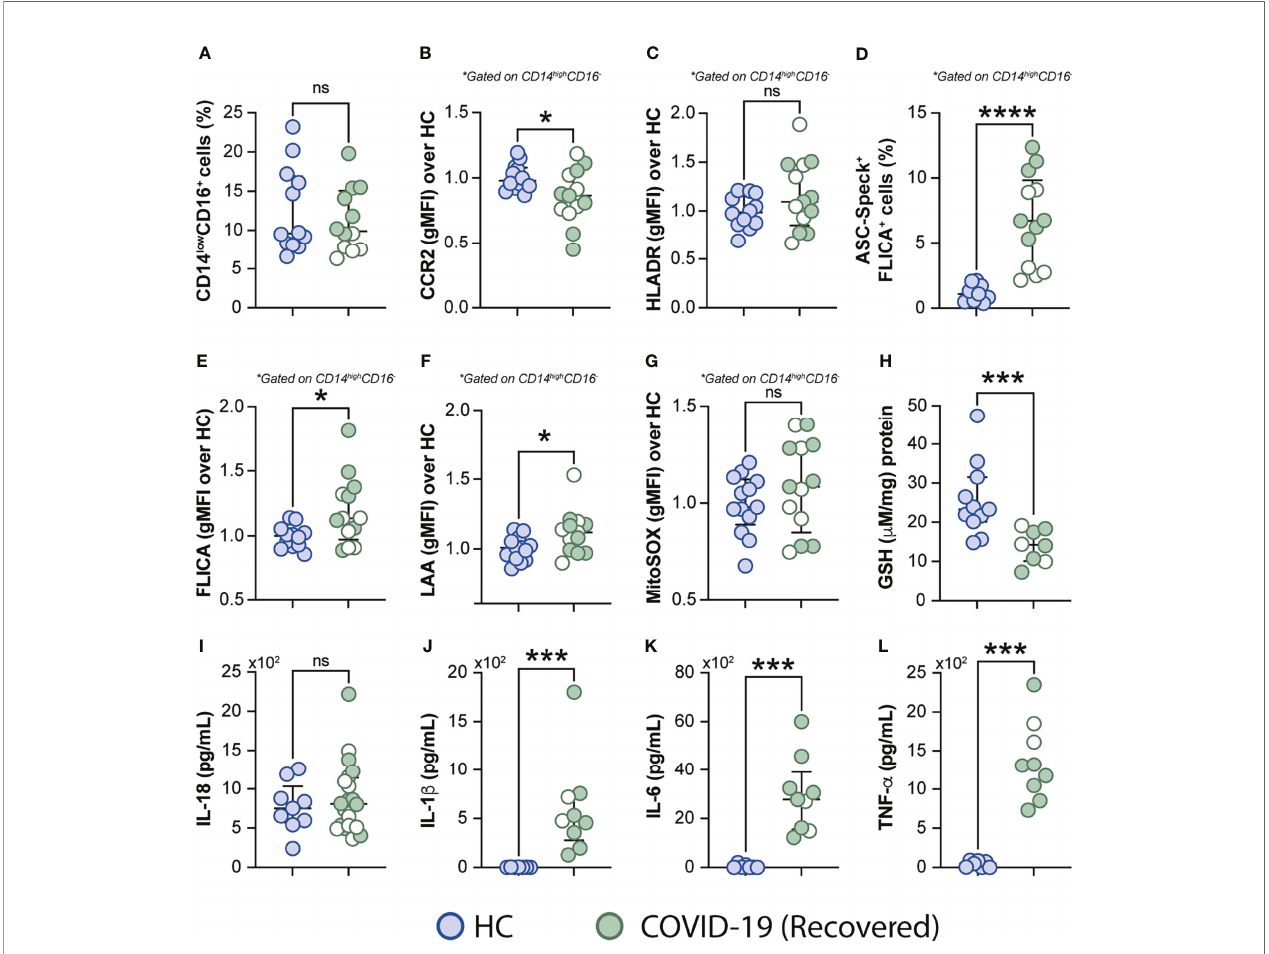
FIGURE 7 | Measurements associated with in fl ammatory responses persist in COVID-19 patients after short-term recovery. Oxidative stress and in fl ammatory markers were compared between HCs and COVID-19 patients after recovery (median of 52 days IQR: 47.3 – 75.3, after infection onset) as follows: (A) Percentage of patrolling CD14 low CD16 + monocyte subset, (B) CCR2 expression on monocytes, (C) HLADR expression on monocytes, (D) Percentage of ASC-speck + CD14 high CD16 - cells, (E) caspase-1 activity measured by FLICA staining, (F) lipid peroxidation (LAA) and (G) mitochondrial superoxide (MitoSOX) in classical monocytes, (H) intracellular glutathione levels in PBMC. (I) IL-18 levels were measured in plasma samples. (J – L) Spontaneous in vitro IL-1 b , IL-6 and TNF a production by PBMC, respectively. Lines represent median values and interquartile ranges. Closed symbols indicate hospitalized patients (inpatients) and open symbols denote mild disease outpatients. Data were analyzed using the Mann-Whitney test. *P < 0.05, ***P < 0.01, ****P < 0.01; ns, not signi fi